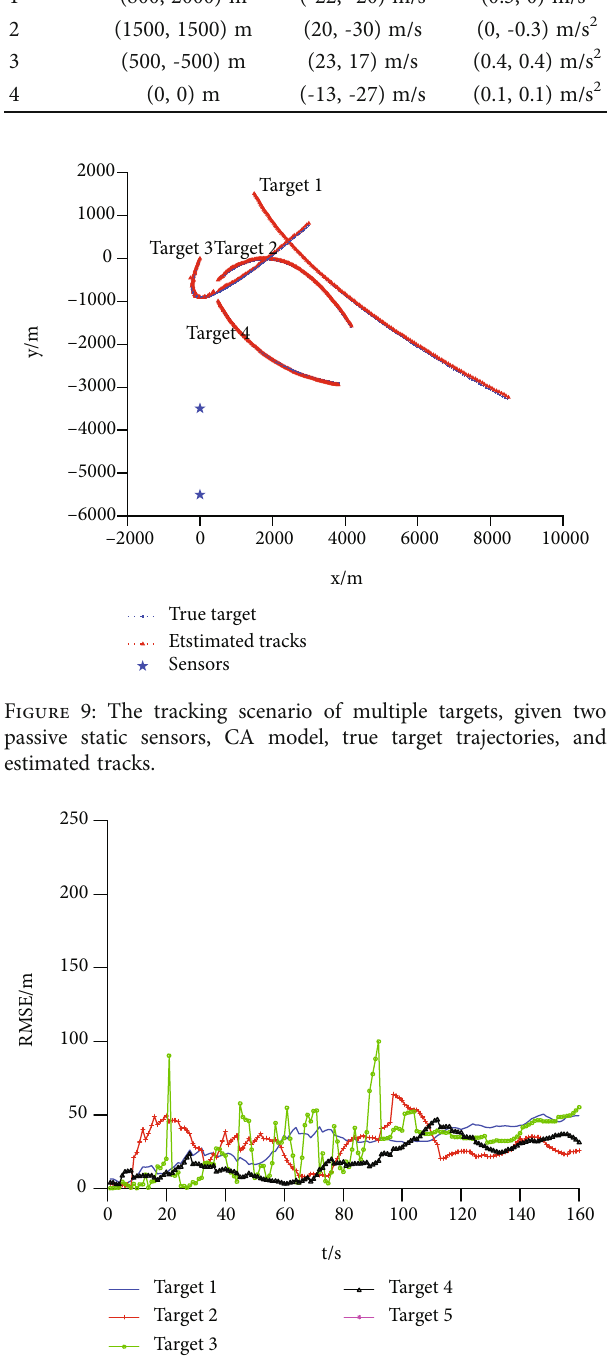
Figure 10: The position RMSE for four targets (CA model).